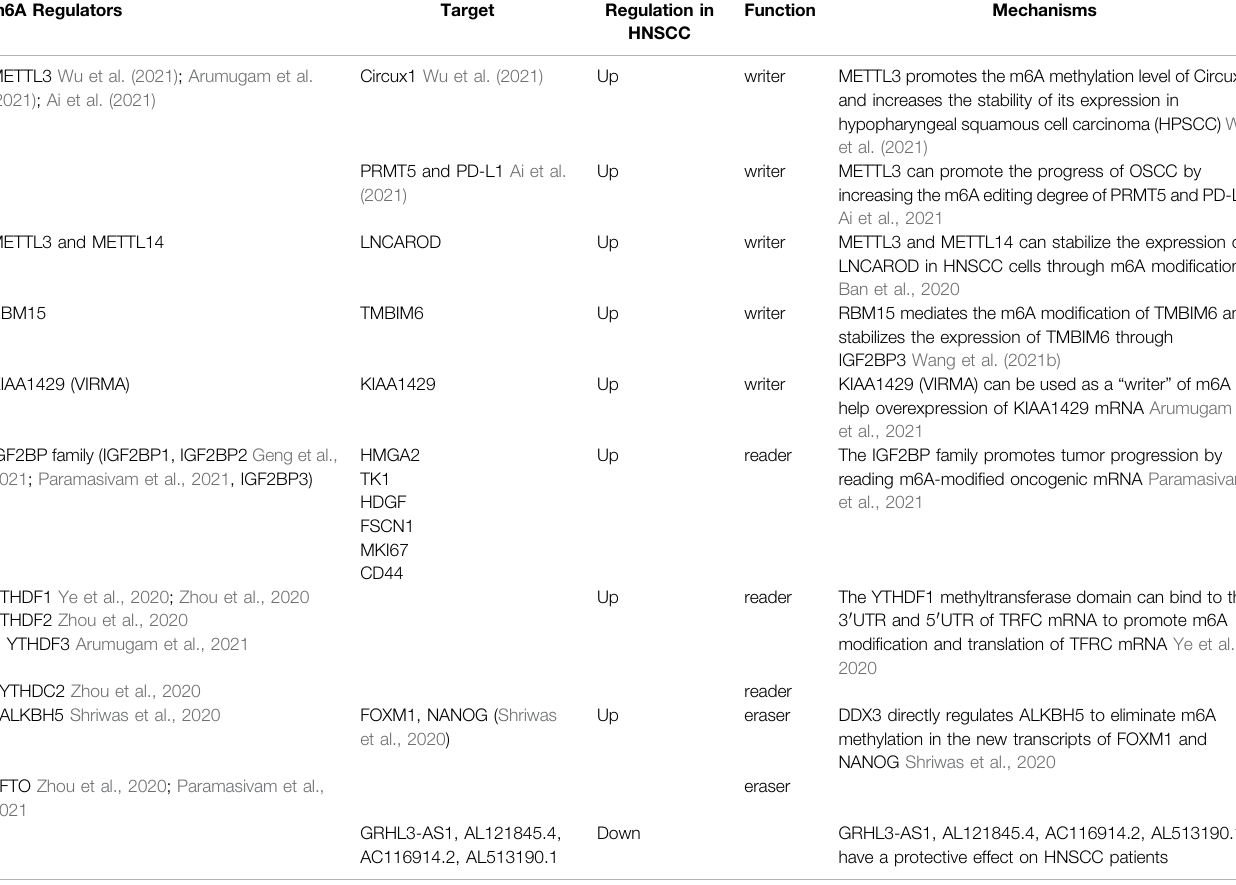
TABLE 1 | Regulation of m 6 A modi fi cation in HNSCC.